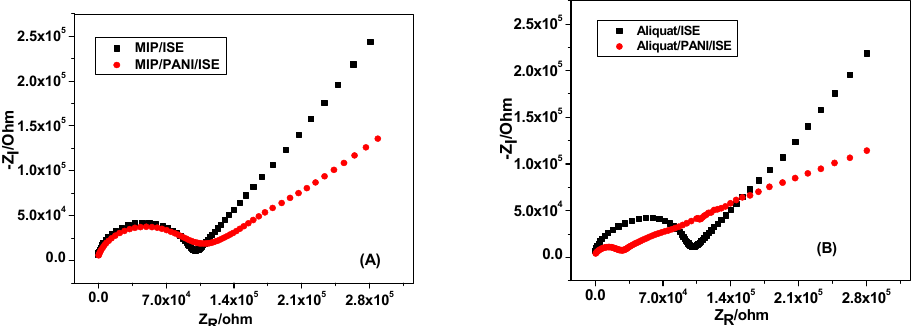
Figure 5. Impedance spectra of the ( A ) MIP; and ( B ) Aliquat based sensors recorded in 10 − 3 M flucarbazone-sodium.